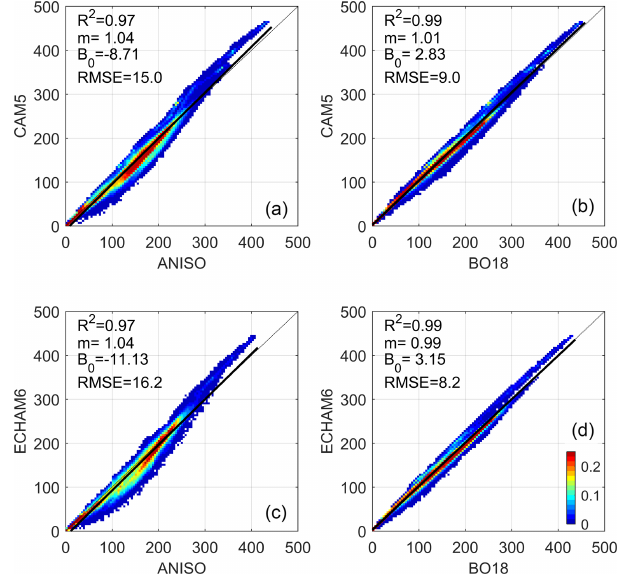
Figure 4. (a–d) Scatter–density regressions of K GCM α ( y axis) and K GCM α emulated with the ANISO semiempirical model and BO18 parameterization using the GCM’s own inputs ( x axis); “ m ”: slope; “ B 0 ”: y intercept. See Fig. 2 caption for a description of the color